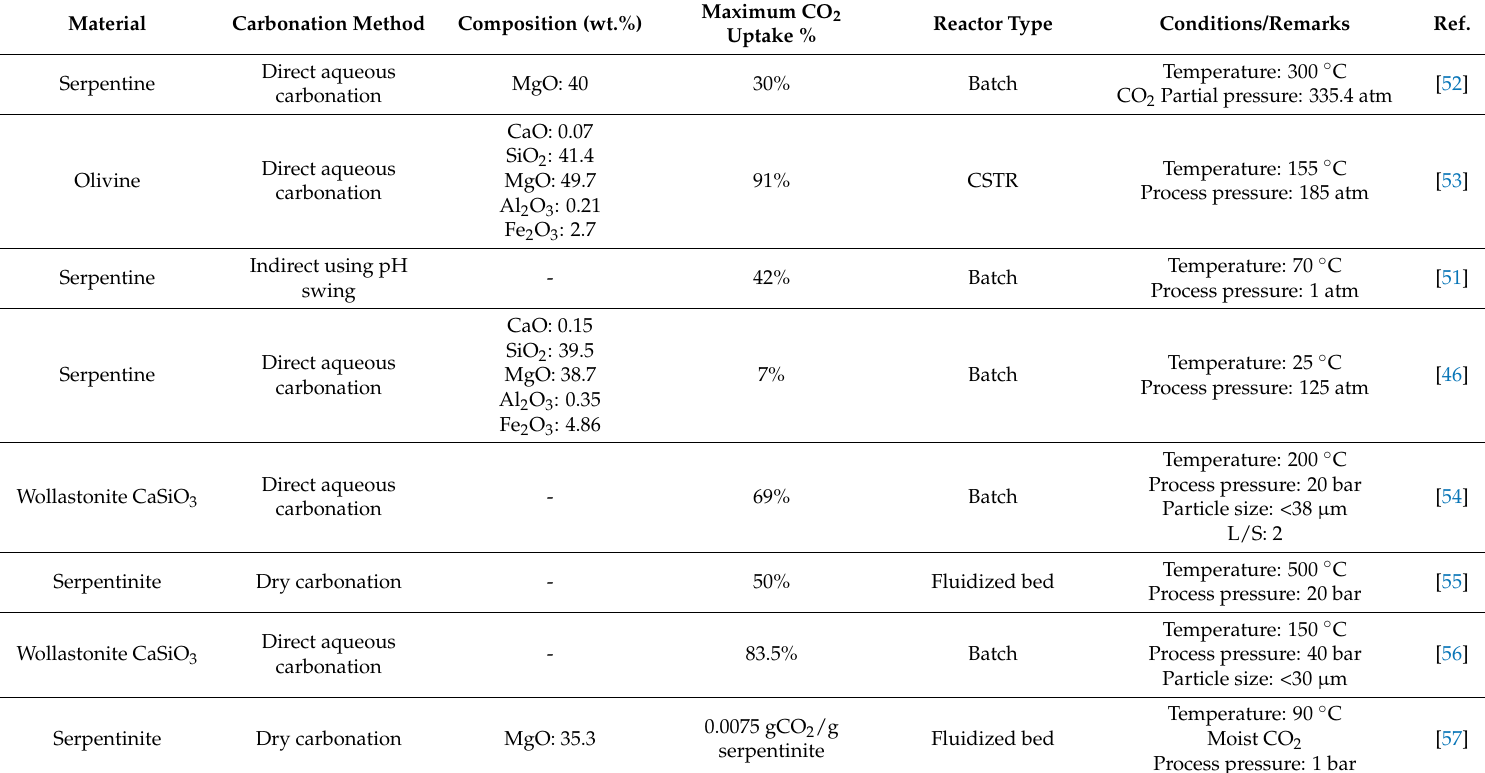
Table 5. Mineral carbonation studies for natural